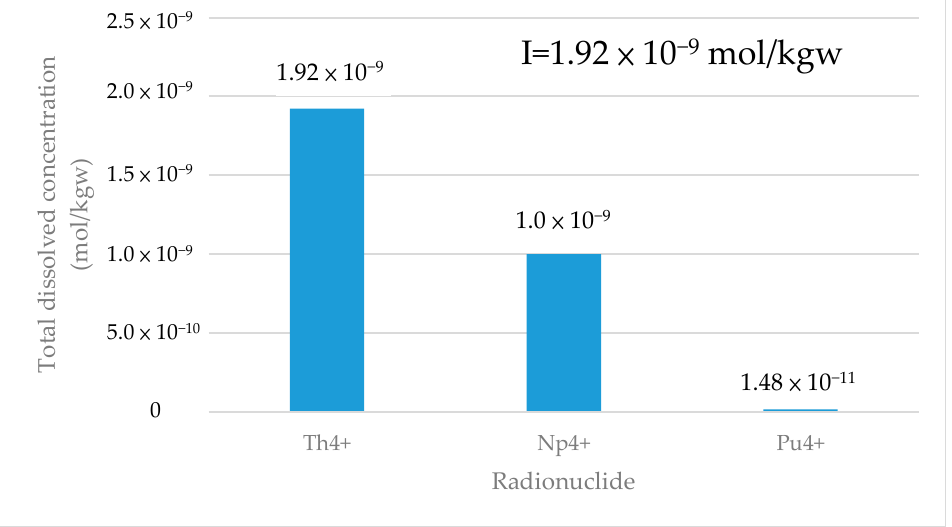
Figure 6. Total dissolved concentrations of the solid compounds Th(OH) 4 , Np(OH) 4 and Pu(OH) 4 in the potential radioactive waste disposal sites.